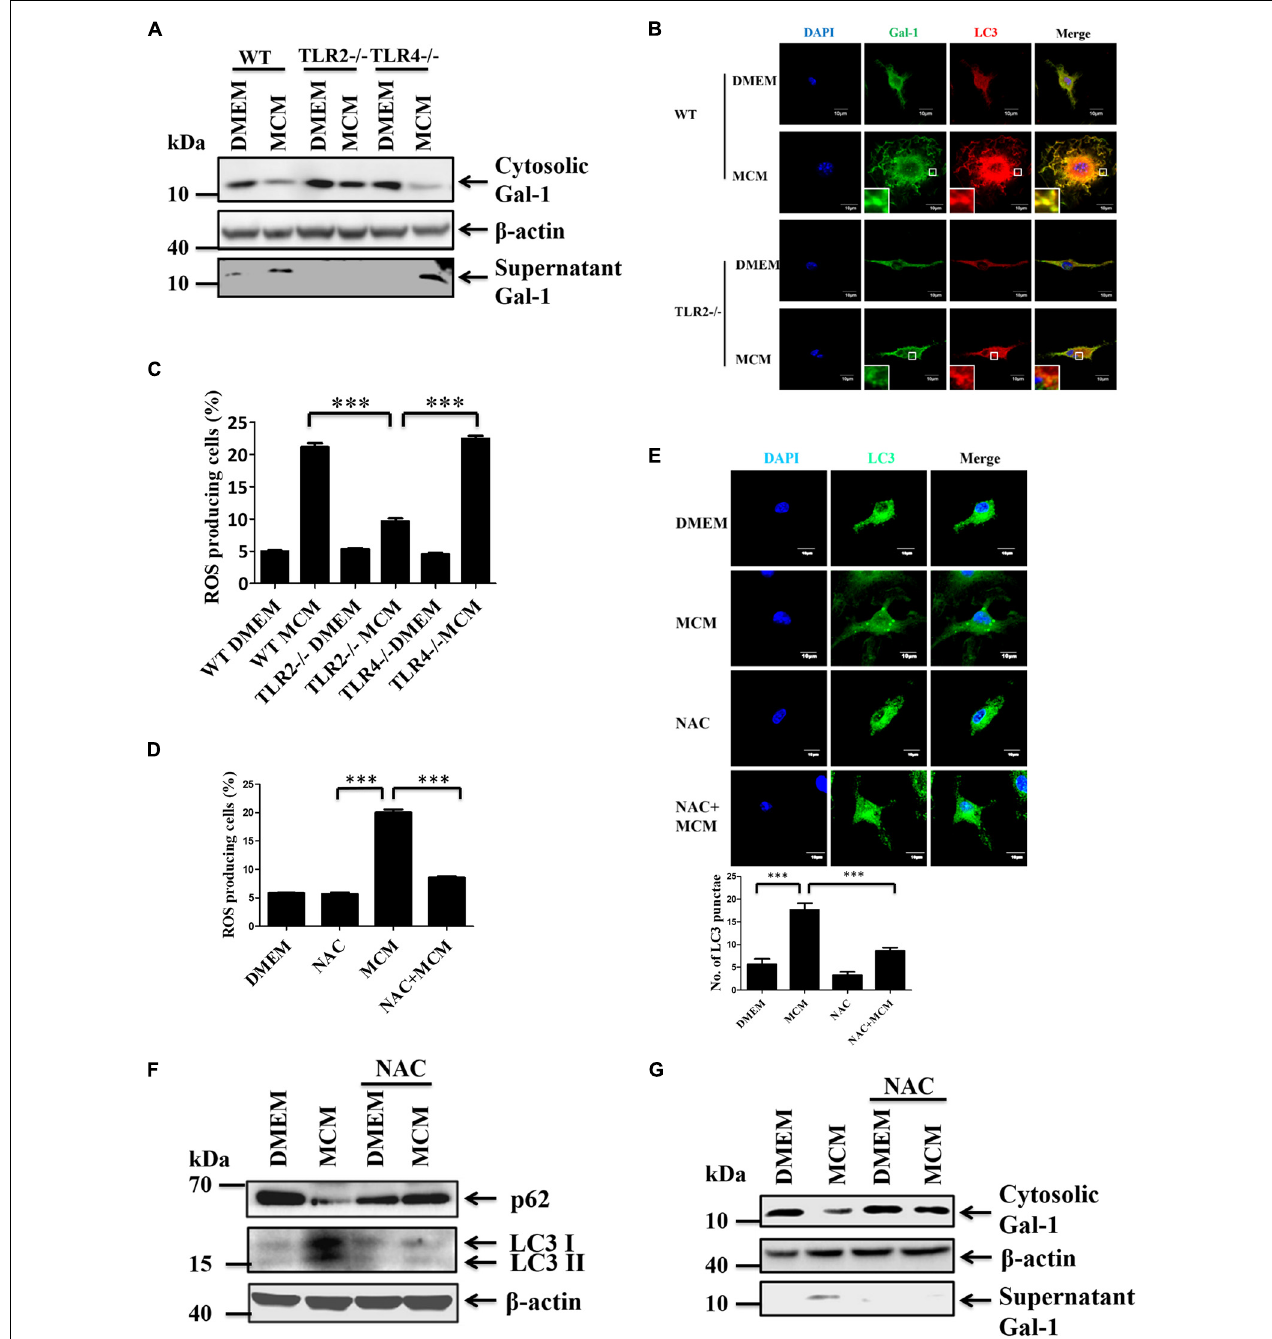
FIGURE 4 | TLR2-mediated ROS production induces autophagy and Gal-1 secretion. (A) WT, TLR2-/- or TLR4-/- BMDMs were treated with MCM for 24 h. The expression of cytosolic Gal-1, β -actin, and supernatant Gal-1 proteins was determined by Western blotting. All blots were derived from a single experiment. (B) WT or TLR-/- BMDMs were treated with MCM for 12 h and then stained with anti-Gal-1 (green) and anti-LC3 (red) antibodies. The co-localization of Gal-1 and LC3 was observed by confocal microscopy. Scale bar = 10 µ m. (C) WT, TLR2-/- or TLR4-/- BMDMs were treated with MCM for 12 h. The ROS production of these cells was analyzed by flow cytometry and quantified. (D–F) BMDMs were pretreated with or without NAC (4 mM) for 1 h and then treated with MCM for another 12 h. The ROS production of these cells was analyzed by flow cytometry and quantified (D) . The LC3 dots were observed by confocal microscopy and quantified (E) . The expression of cytosolic p62, LC3-I/II, and β -actin proteins was determined by Western blotting (F) . All blots were derived from a single experiment. (G) BMDMs were pretreated with or without NAC (4 mM) for 1 h and then treated with MCM for another 24 h. The expression of cytosolic Gal-1, β -actin, and supernatant Gal-1 proteins were determined by Western blotting. All blots were derived from a single experiment. ∗∗∗ p < 0.0001.